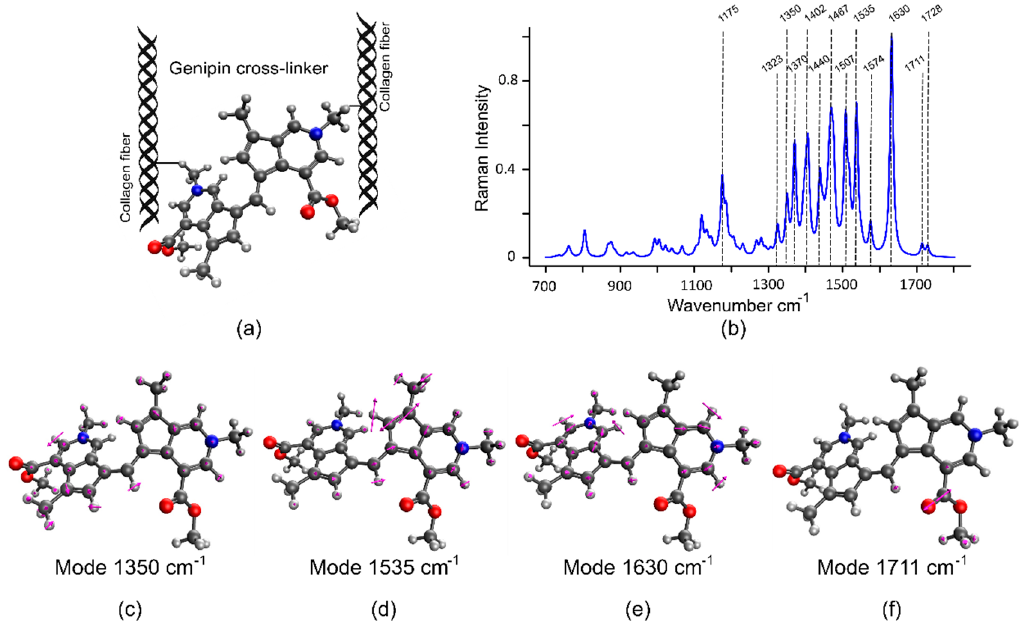
Figure 4. ( a ) Genipin cross-linker. ( b ) DFT-simulated Raman spectra of genipin cross-linker. Prominent Raman vibrational modes of genipin cross-linker: ( c ) mode 1350 cm − 1 , ( d ) mode 1535 cm − 1 , ( e ) mode 1630 cm − 1 , and ( f ) mode 1728 cm − 1 . Atom notation—blue: nitrogen, grey: carbon, red: oxygen, light grey: hydrogen.